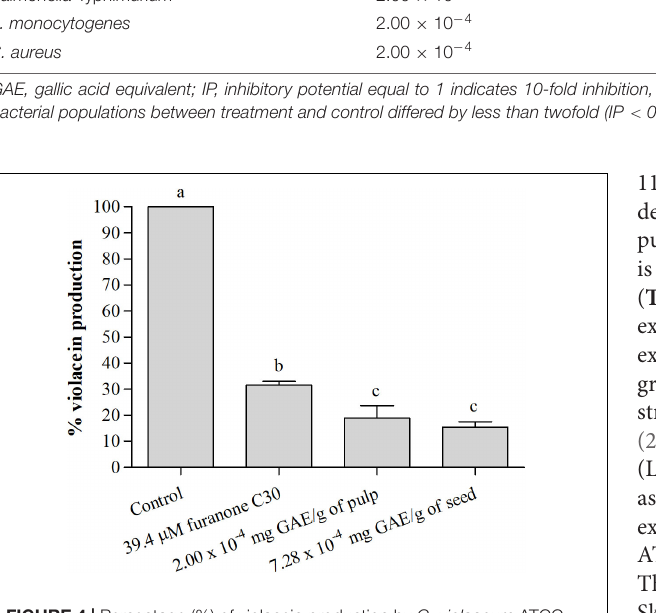
FIGURE 4 | Percentage (%) of violacein production by C. violaceum ATCC 12472 in the absence and presence of the active films incorporating pulp and